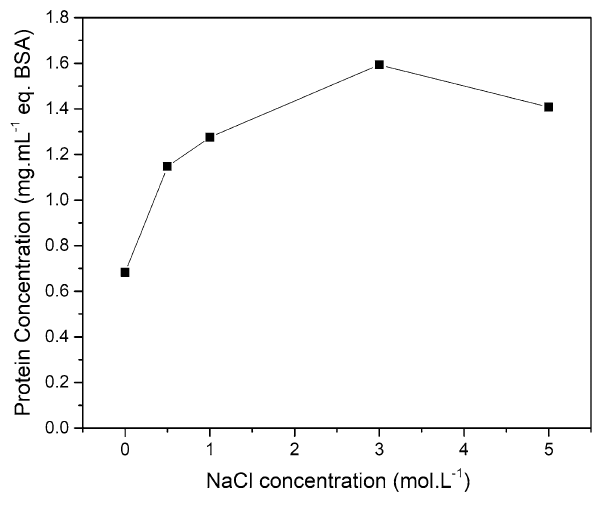
Fig. 1 Effect of NaCl concentration to protein extracted Fig. 2 Effect of initial pH on % removal and sludge